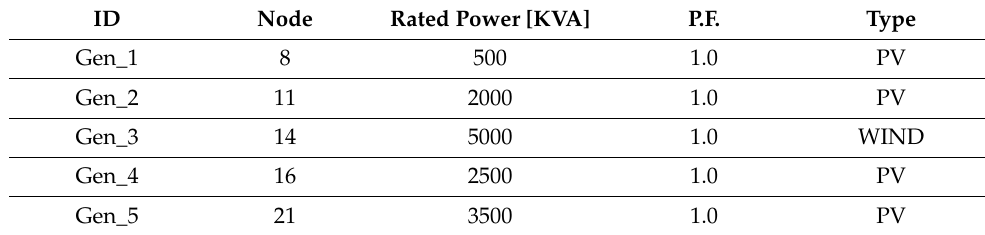
Table A3. Generators main